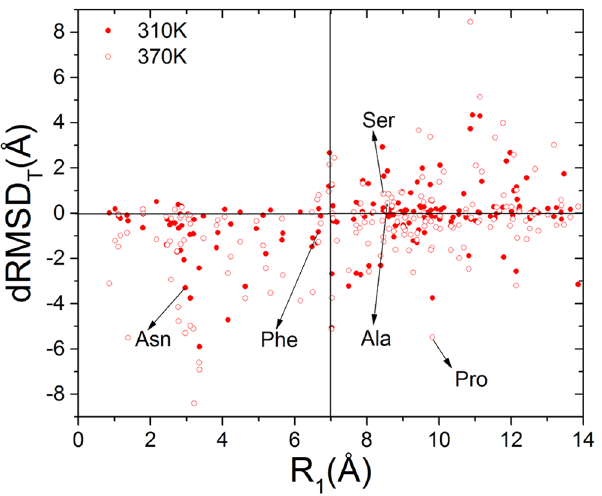
Fig 7. The dRMSD T versus R 1 between the MD-MC and the MD trajectories with identical initial-target structure pairs. The details of the marked five points are to be presented Fig 8.